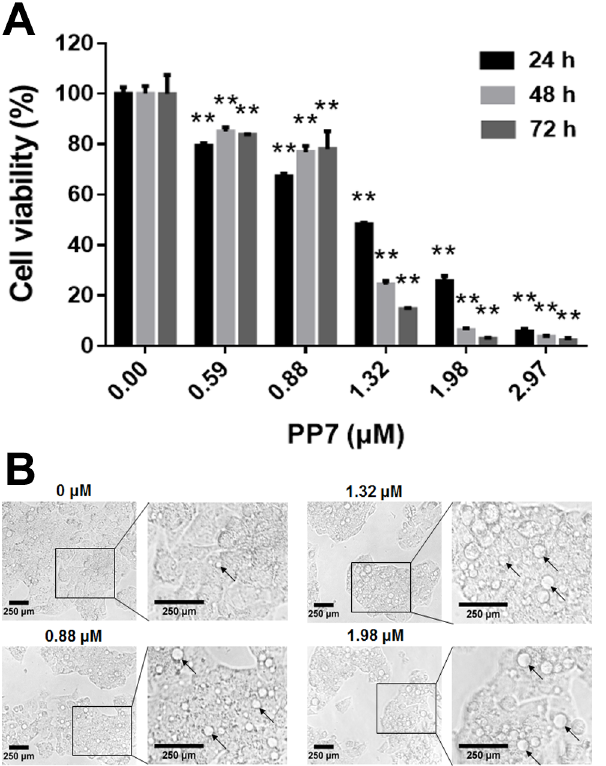
Fig 1. PP7 inhibits the proliferation of HepG2 cells. (A) Cells were treated with indicated concentrations of PP7 for 24, 48 or 72 h. The cell viability was analyzed by MTT assay. Values represent the mean ± SD of at least three independent experiments. ** P < 0.01, versus control groups. (B) Morphology of HepG2 cells treatment with PP7 or vehicle control for 24 h was observed under light microscopy (10X objective). Scale bars represent 250 μ